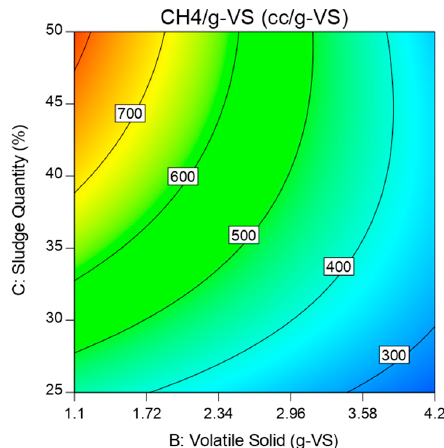
Figure 17. Interaction plot clarifying the effects of interaction between volatile solid and sludge quantity on CH 4 g –1 -VS.